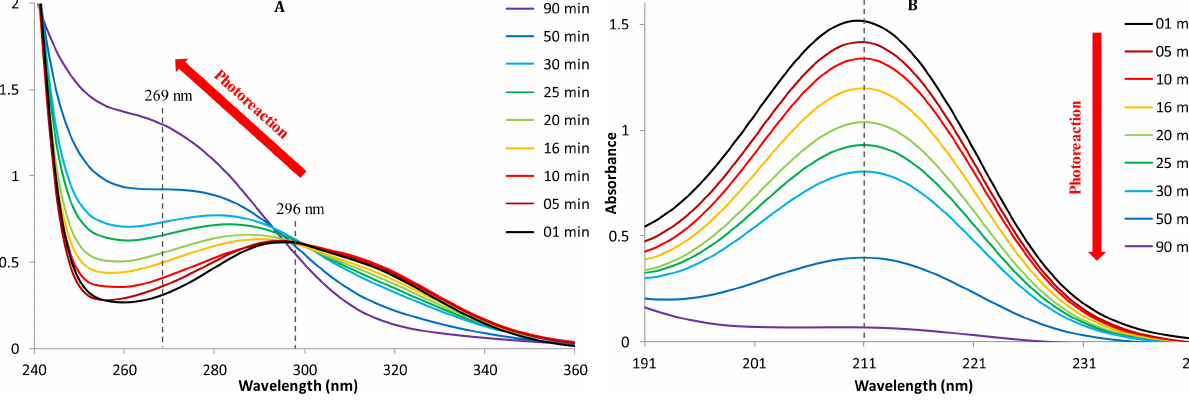
Fig. 4. UV absorption spectra of the solutions sampled during experiment A (with catalase added prior to analysis), (A) : from 240 to 360nm; and (B) : diluted by 100 from 191 to